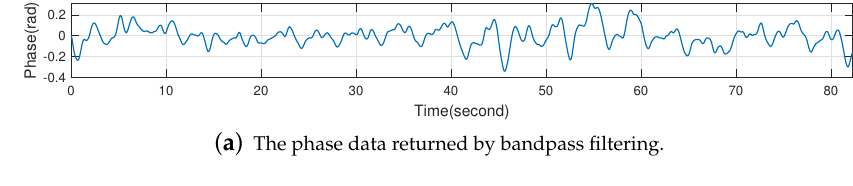
( a ) The phase data returned by bandpass filtering.